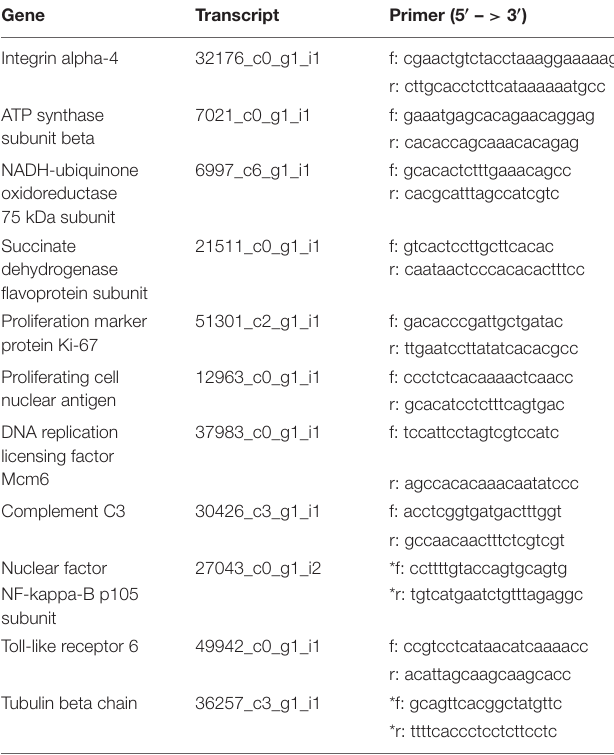
TABLE 1 | Primers and reference transcripts for selected genes in the qPCR array. Gene Transcript Primer (5 (cid:48) – > 3 (cid:48)